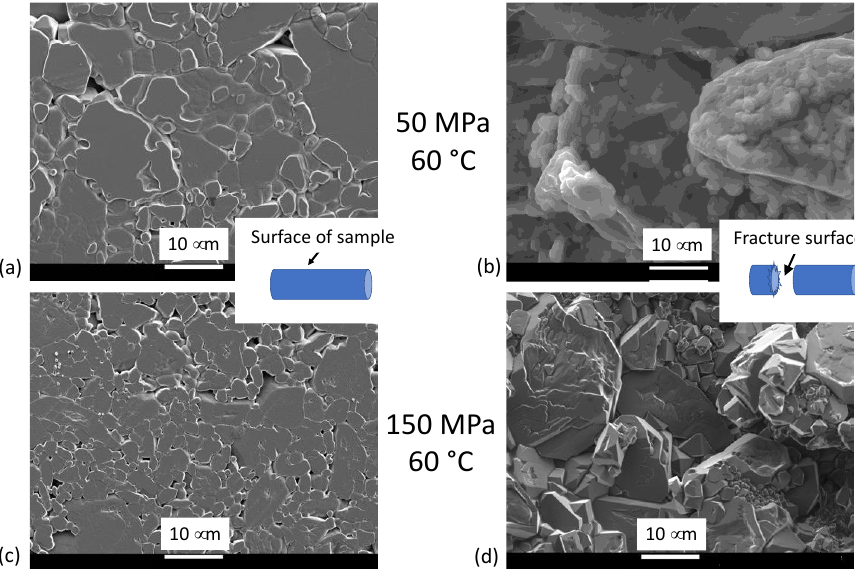
Figure 8. SEM micrographs of KDP samples after fracture during late-stage CSP for ( a , b ) p = 50 MPa at 60 °C; ( c , d ) p = 150 MPa at 60 °C. ( a , c ) show intact outer surfaces of the samples after CSP; ( b , d ) show the fracture surfaces.